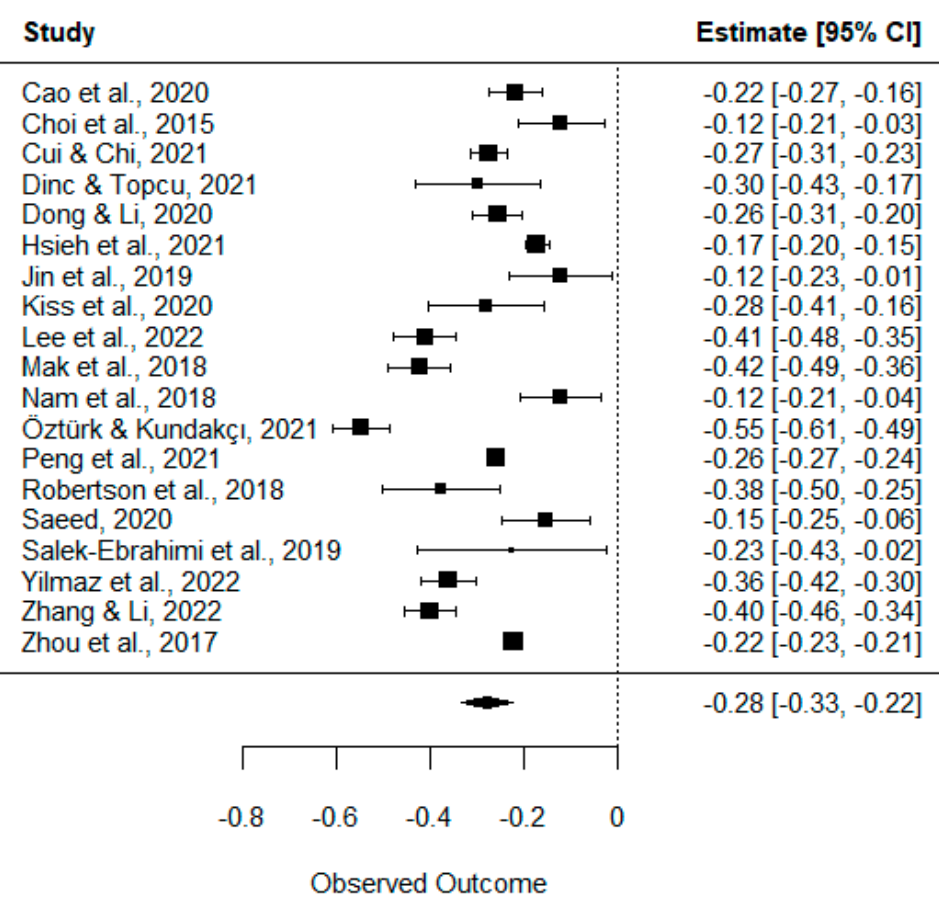
Nurs. Rep. 2023 , 13 , FOR PEER REVIEW Figure 2. Effect size for the relationship between PIU and resilience [33–35,49–64]. Figure 2. Effect size for the relationship between PIU and resilience. Although the funnel plot is not fully symmetrical (see Figure 3), both the Egger regression test ( z = 0.2996, p = 0.76) and the Begg and Mazumdar rank correlation test ( τ = − 0.0292, p = 0.89) show non-significant results, thus ruling out the presence of publication bias. Likewise, the calculation of the number of safety according to Rosenthal’s method yielded a value of n = 18,877 ( p < 0.001), making 18,877 unpublished studies with an effect size equal to zero necessary to make the p-value non-significant, exceeding the critical value which, for this meta-analysis, is set at 105 studies, according to the formula (5 × k) + 10, and k being the number of studies included in the meta-analysis [44].